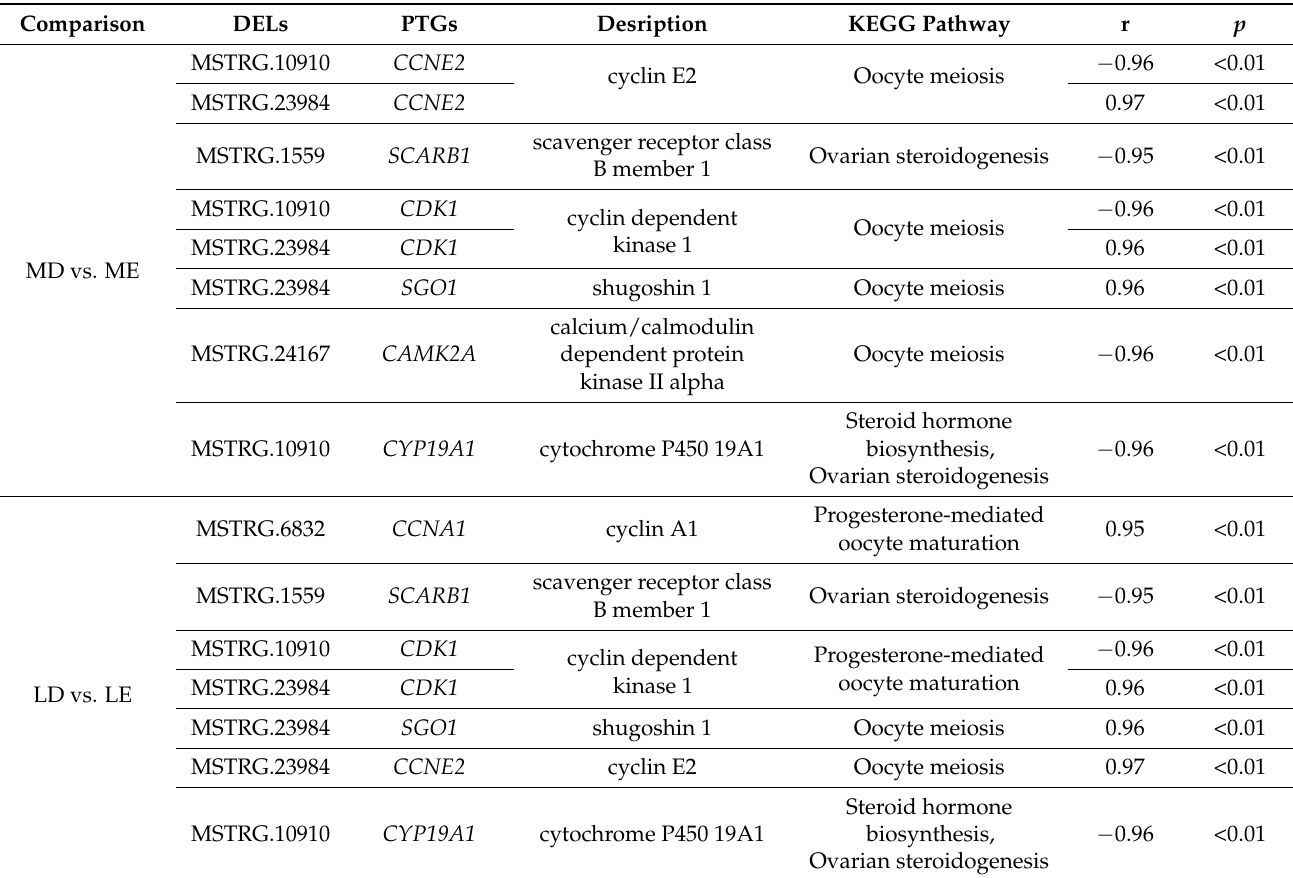
Table 1. The correlation between DELs and the PTGs that are involved in estrus expression.